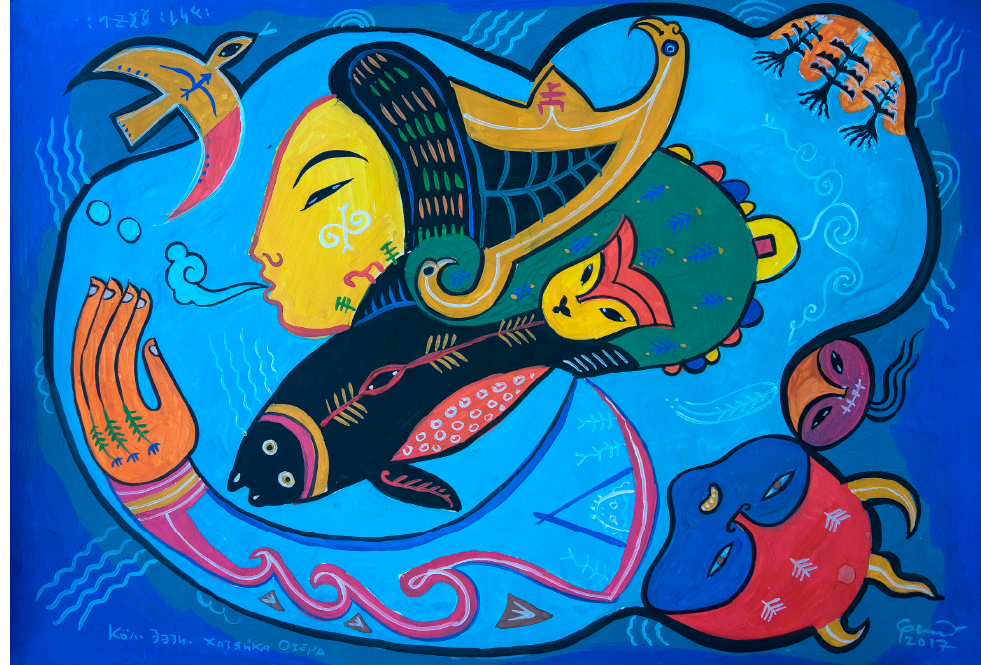
Figure 1. Sergei Dykov, Lady of the Lake , 2017, 43 × 61 cm, painting on paper. Photo: Andrzej Rozwadowski.